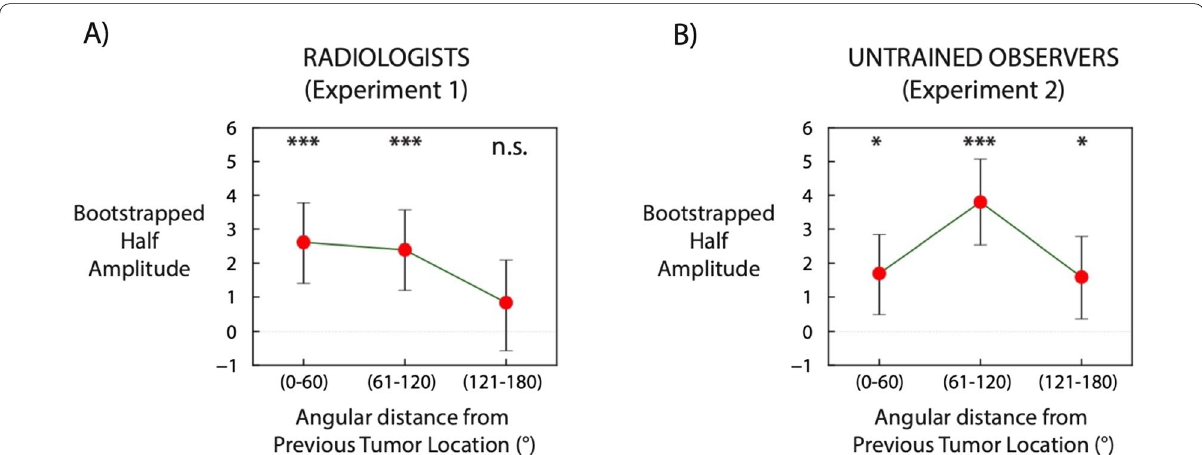
Fig. 5 Spatial tuning of serial dependence. A refers to Experiment 1, whereas B refers to Experiment 2. Each red dot refers to a different relative angular distance between current lesion and lesion in the 1‑back trial, super‑subject bootstrapped mean. For example, a bin distance 0° indicates that current and previous simulated tumor presented at the same location (30° of angular distance, for example). Error bars are bootstrapped 95% confidence intervals. Dashed line indicates half‑amplitude zero (no